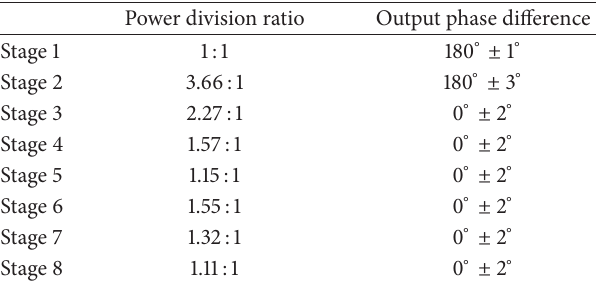
2.2.3. SIW Slot Array Antenna. As is shown in Figure